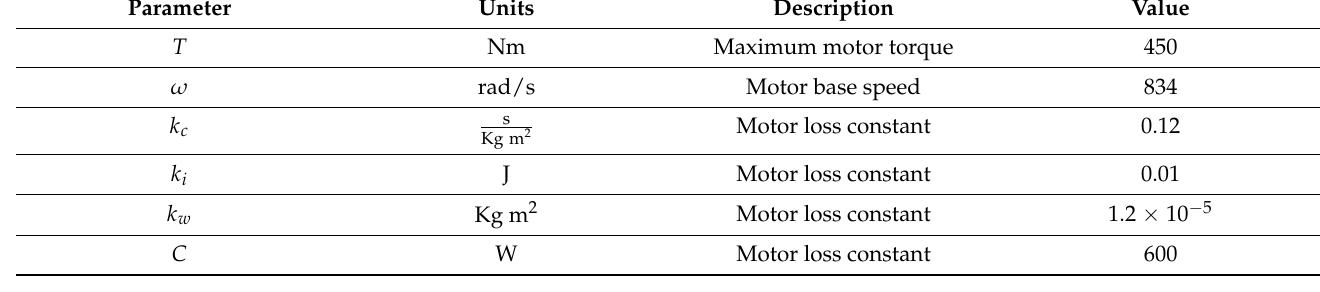
Figure 10. Motor loss model. Adapted from [16], MathWorks: 2020. Table 3. Motor model parameters. Adapted from [16], MathWorks: 2020.